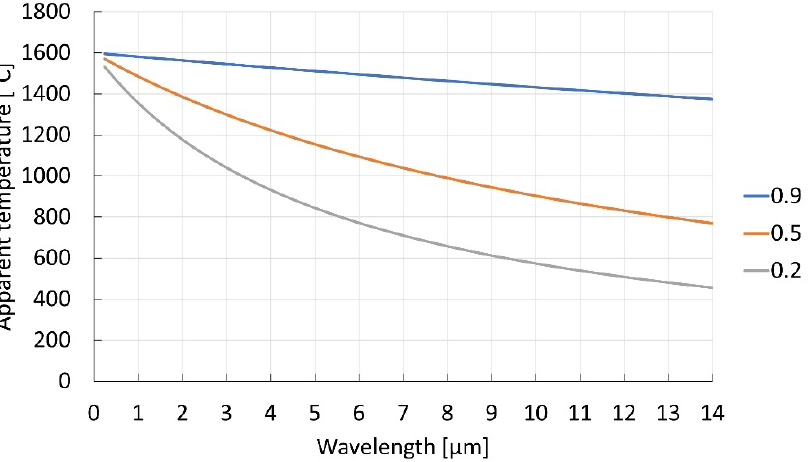
Figure 2. Apparent temperature of an object with a true surface temperature of 2000 K depending on wavelength for three different emissivity values ε .